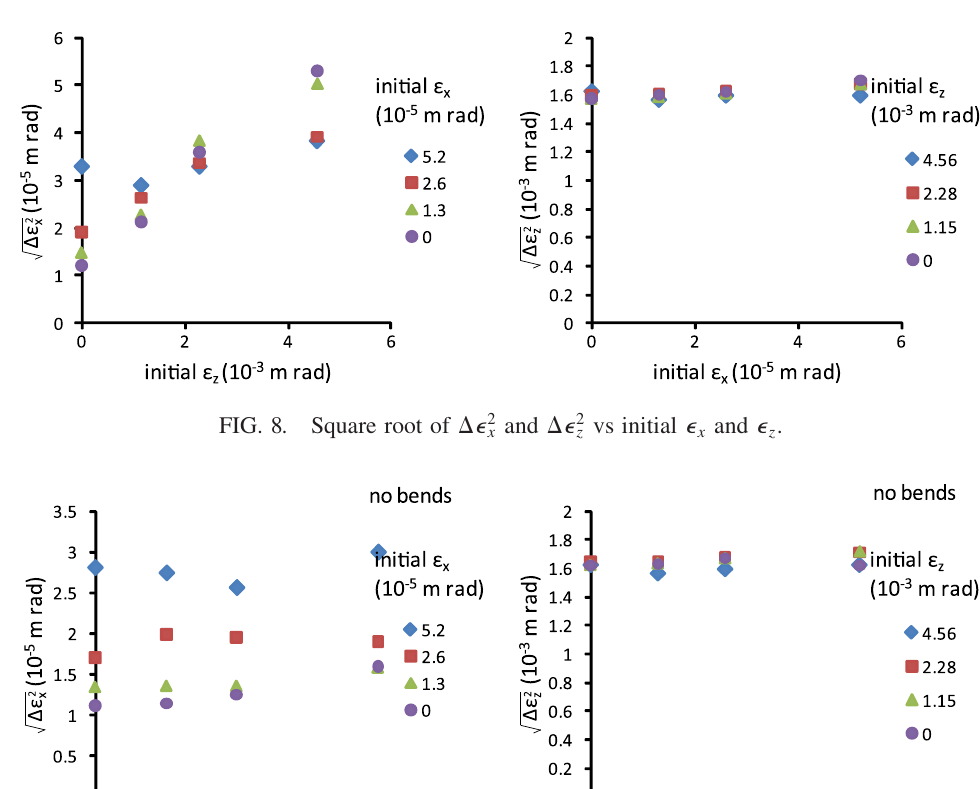
and (cid:1) (cid:1) 2 vs initial (cid:1) x z